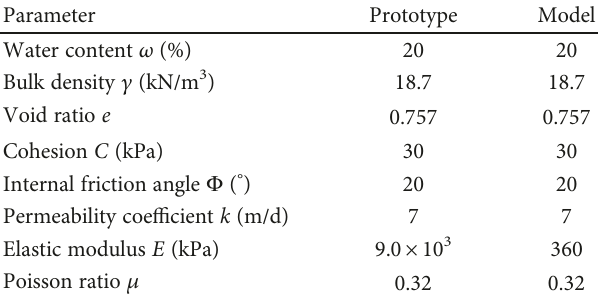
Table 2: Physical parameters of